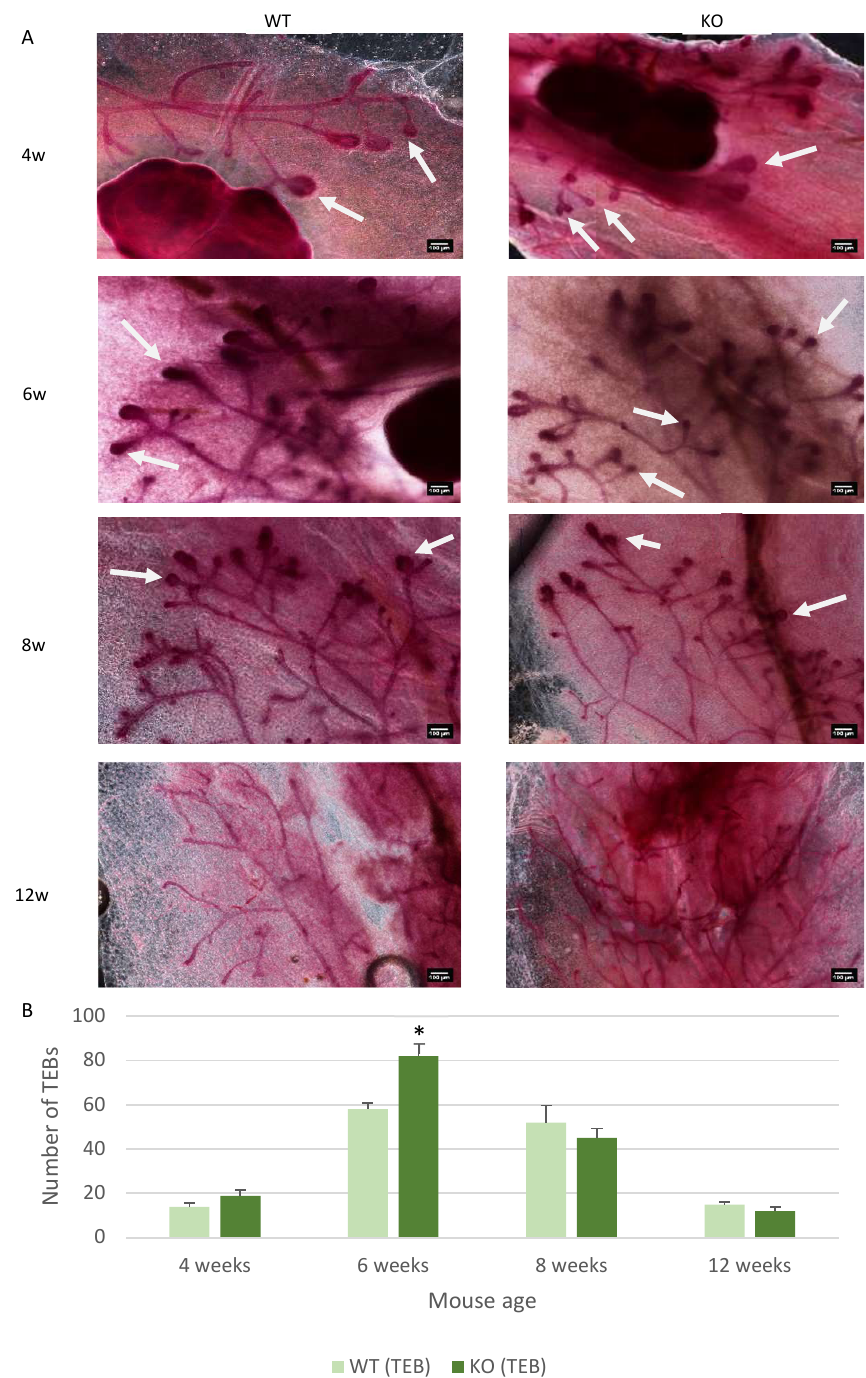
Figure 3. Csmd1 KO leads to increased terminal end bud number during duct development. ( A ) Images of the whole mount stained mammary glands taken at x4 objective. The terminal end buds are identified in the images by the white arrows and the scale is 100 µ m. ( B ) Graph depicting the changes in terminal end bud number between the WT and KO mice, changes were observed at 6 weeks of age (* p < 0.05). The numbers of animals for each time point included 4-week-old mice ( n = 12: WT; n = 10 KO), 6-week-old mice ( n = 5: WT; n = 10 KO), 8-week-old mice ( n = 7: WT; n = 7 KO), 12-week-old mice ( n = 7: WT; n = 7